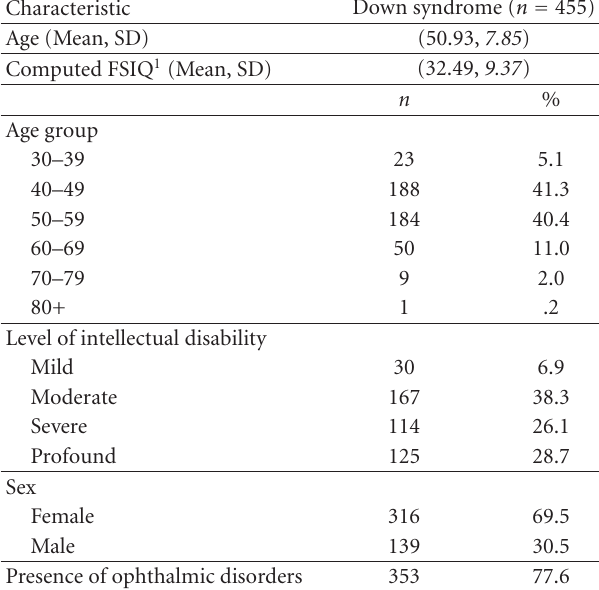
Table 1: Participant